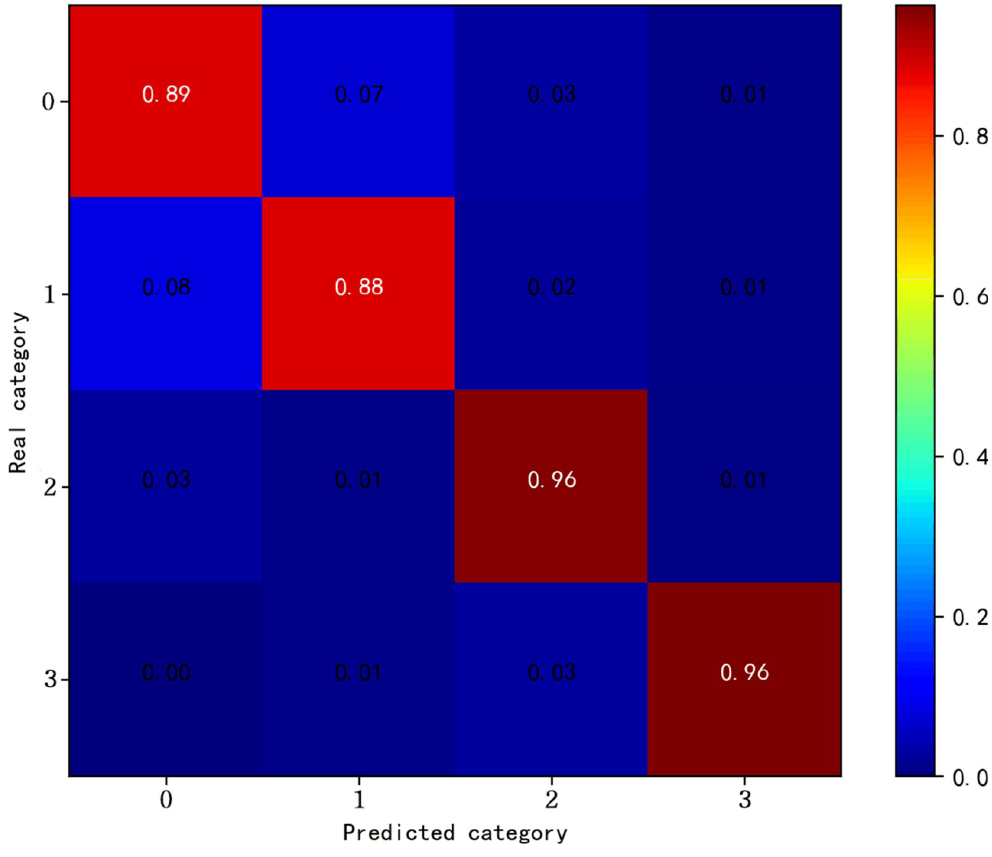
Fig 14. Confusion matrix of the proposed model on the TianChi ECG signal database test set at CR = 0.1. https://doi.org/10.1371/journal.pone.0284008.g014 Table 10. Accuracy of different classification methods in the TianChi ECG signal database test set at different compression ratios. CR